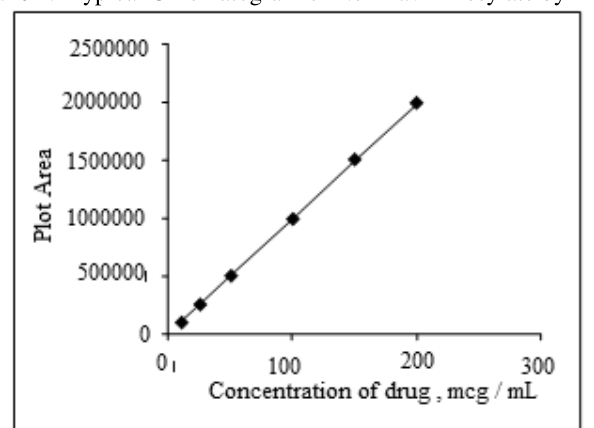
Figure 1 . Typical Chromatogram of Nelfinavir Mesylate by HPLC